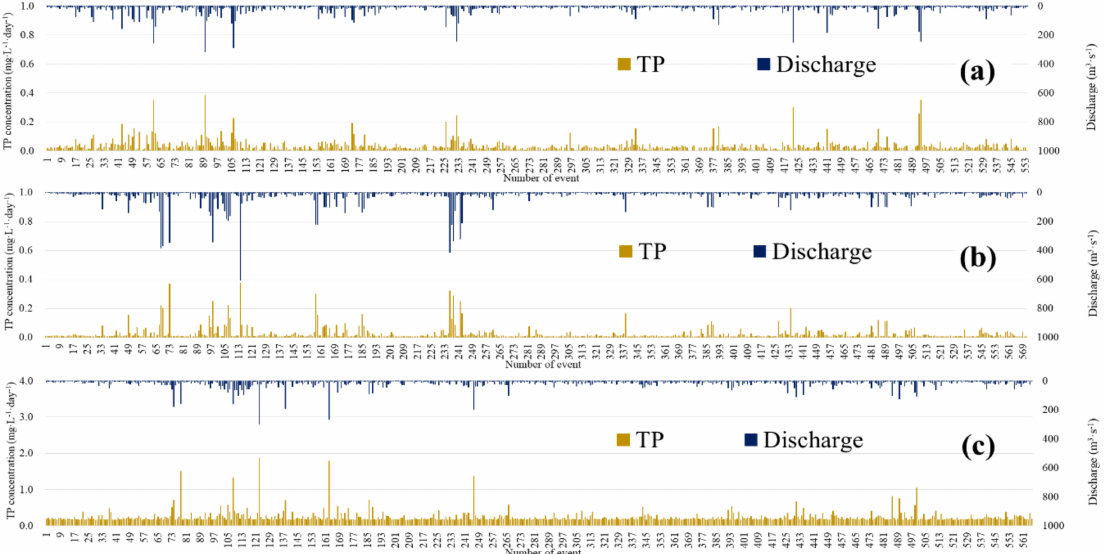
Figure 3. Variations in the discharge and BOD concentration according to the date of the rainfall event: ( a ) JJ watershed; ( b ) HC watershed; ( c ) BH watershed.